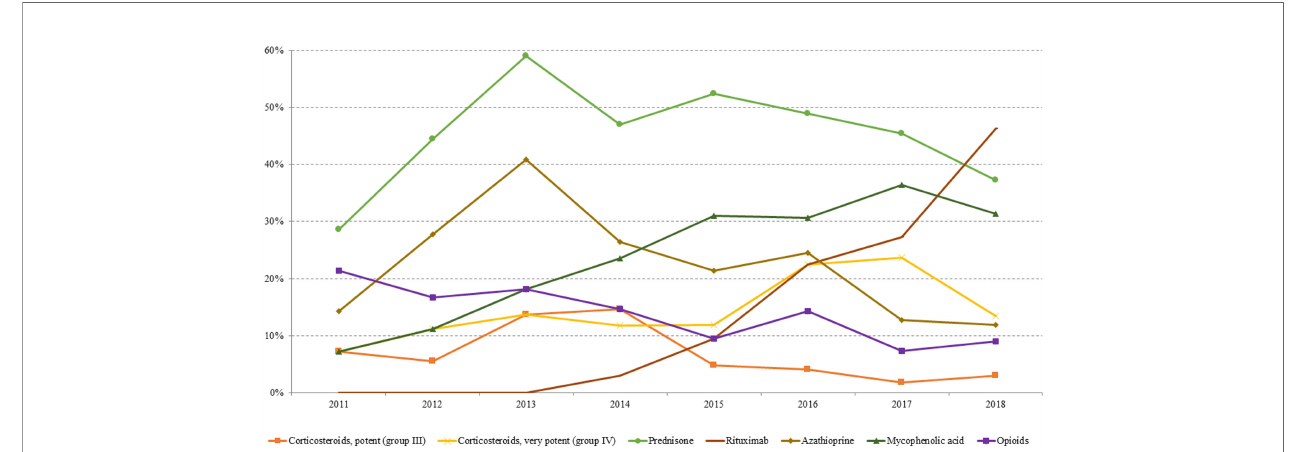
FIGURE 3 | Prevalence trend (2011 – 2018) of the investigated drugs used for pemphigus management: topical corticosteroids, prednisone, azathioprine, mycophenolic acid, rituximab,